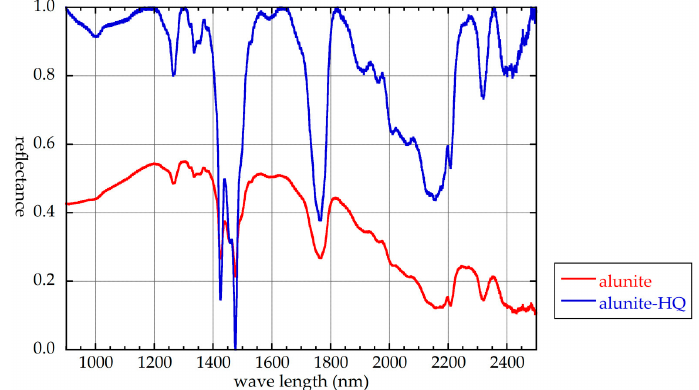
Figure 1. Reflectance spectra of alunite without and with hull quotient (HQ).